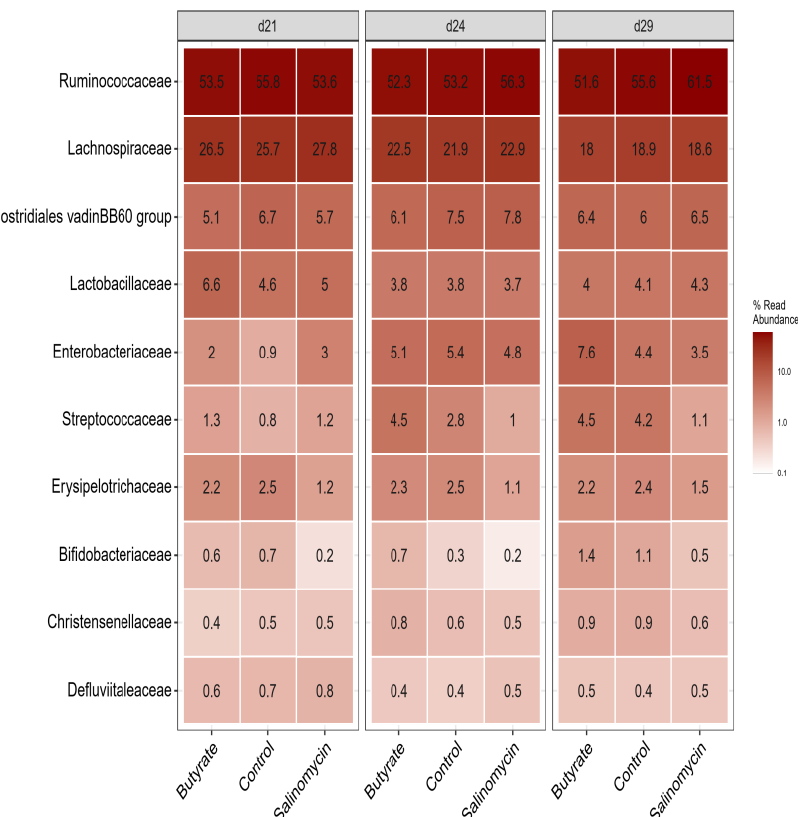
Figure 5. Heatmap showing the relative abundance of the top 10 most abundant microbiota at the family level across all ileum samples (irrespective of treatment or age) and visualized for each age and treatment group, separately. The samples were collected on days 21, 24, and 29 of age from chickens administered butyrate (UltraGuard™ -DUO, 500mg/kg), salinomycin (Sacox ® , 69 mg/kg), or no dietary supplement (control).